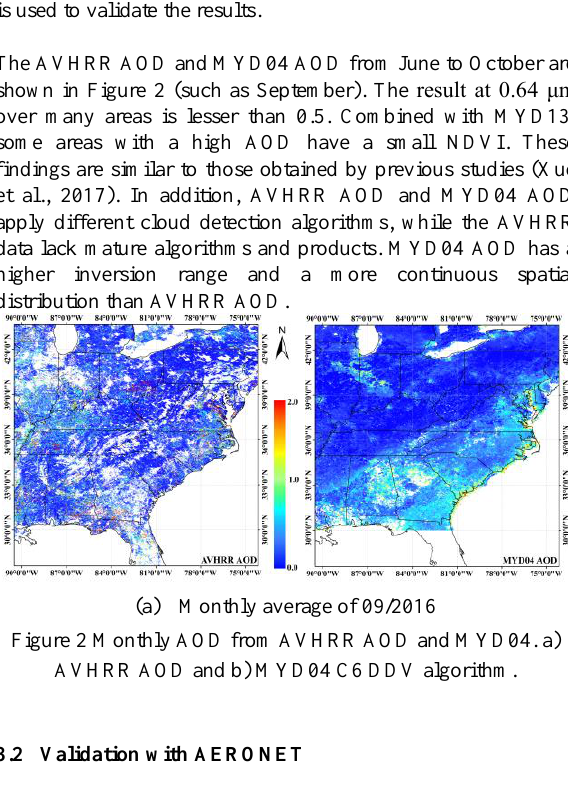
Figure 3 Retrieval results of AERONET measurements and AVHRR